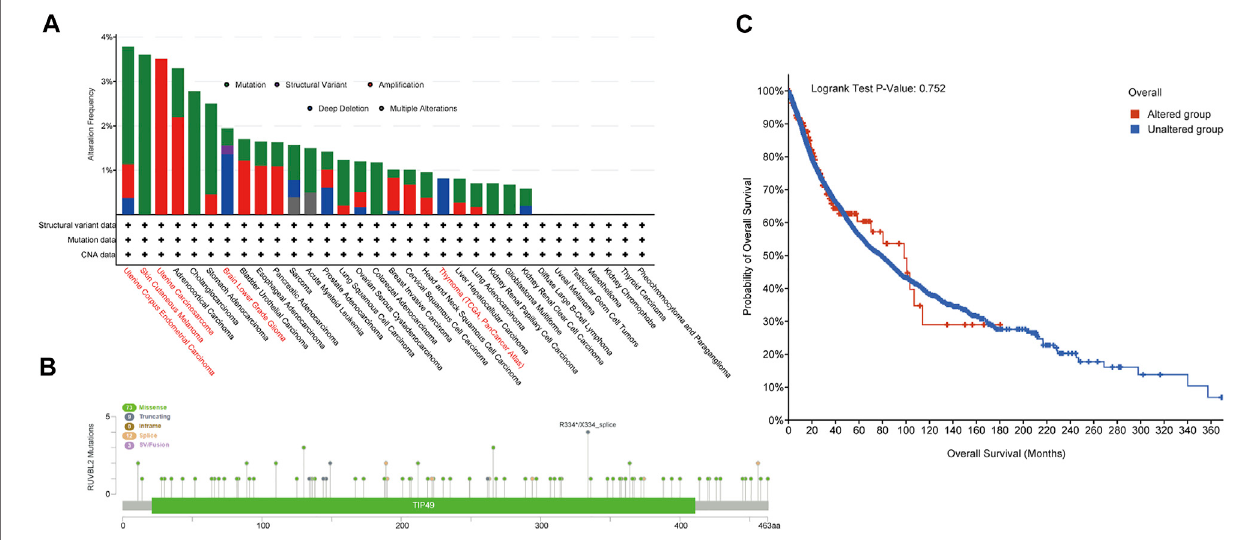
FIGURE 4 | Mutation characteristics of Reptin. (A) The frequencies of different genetic variant types in all TCGA tumor samples. (B) The distribution of Reptin mutation sites. (C) The comparison of clinical survival prognosis analysis between the Reptin altered group and the unaltered group.